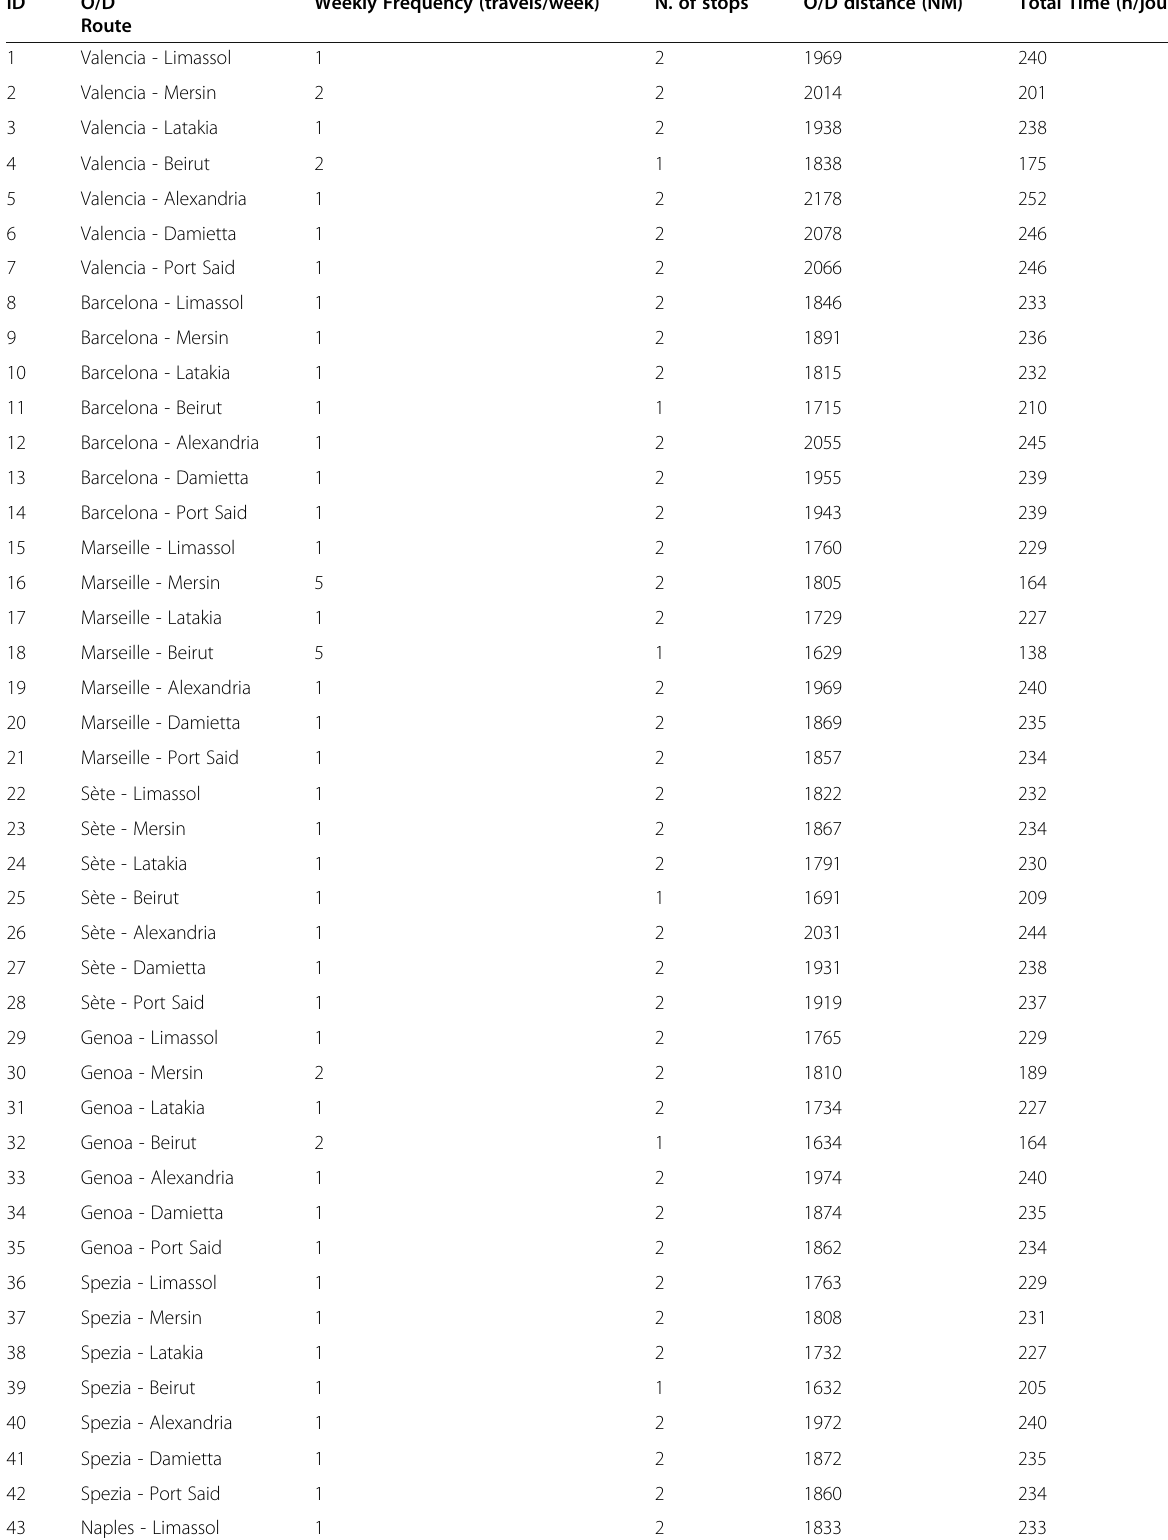
Table 23 Operational features of the optimized